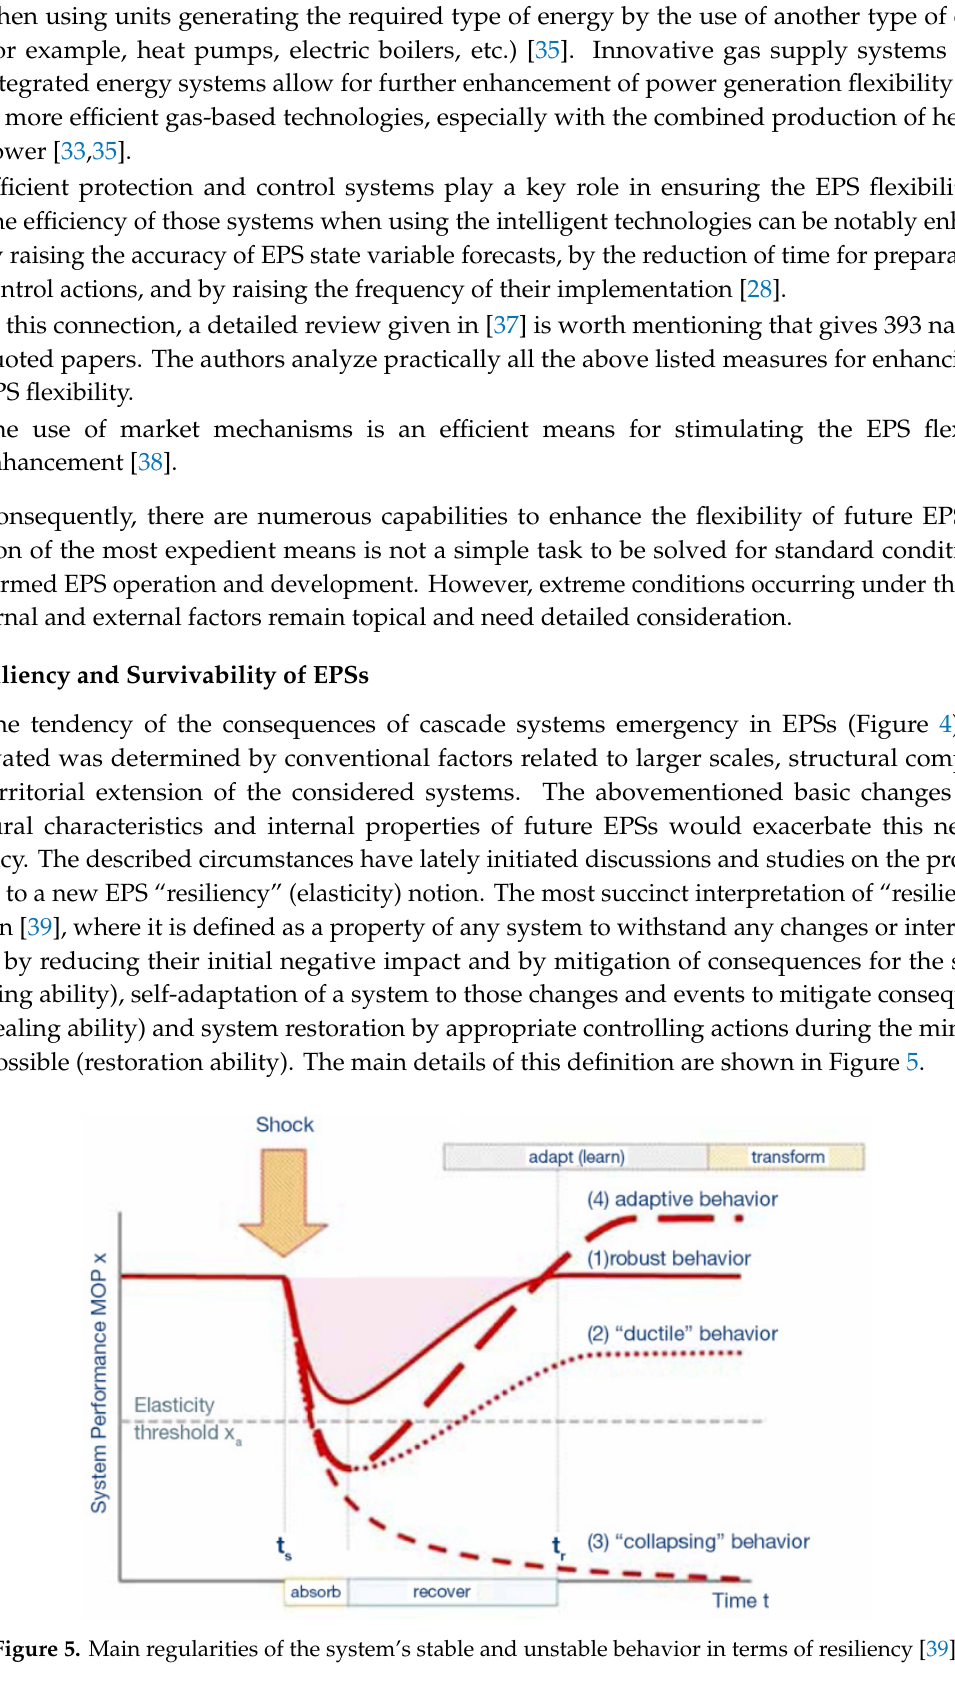
Figure 6. Illustration of EPS behavior in terms of survivability [43,44]. The relations between EPS resiliency and flexibility are of interest. An analysis of definitions of those properties shows that a higher flexibility of the system causes growth in damping and adaptation ability of the EPS that are characteristic of resiliency. 6. Possible Measures for Enhancing the Resiliency/Survivability of EPSs These measures include [28]: •